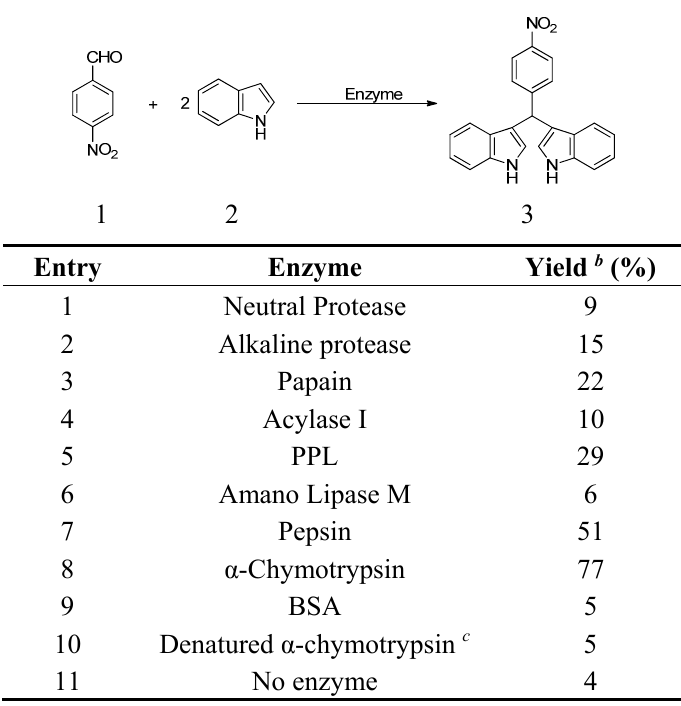
Table 1. Catalytic activities of different enzymes a .